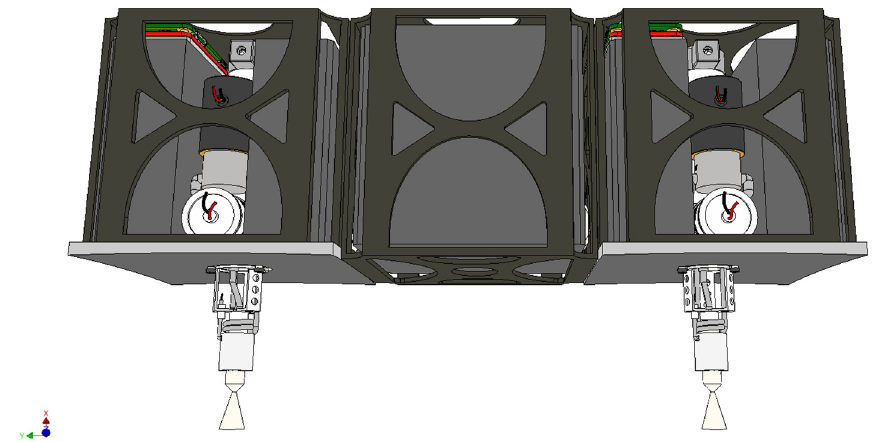
Figure A5. MIMPS-G500mN on a 9U CubeSat, 1 N Thrust, and one extension tank. I tot ~4500 N s using ASCENT (formerly AF-M315E).